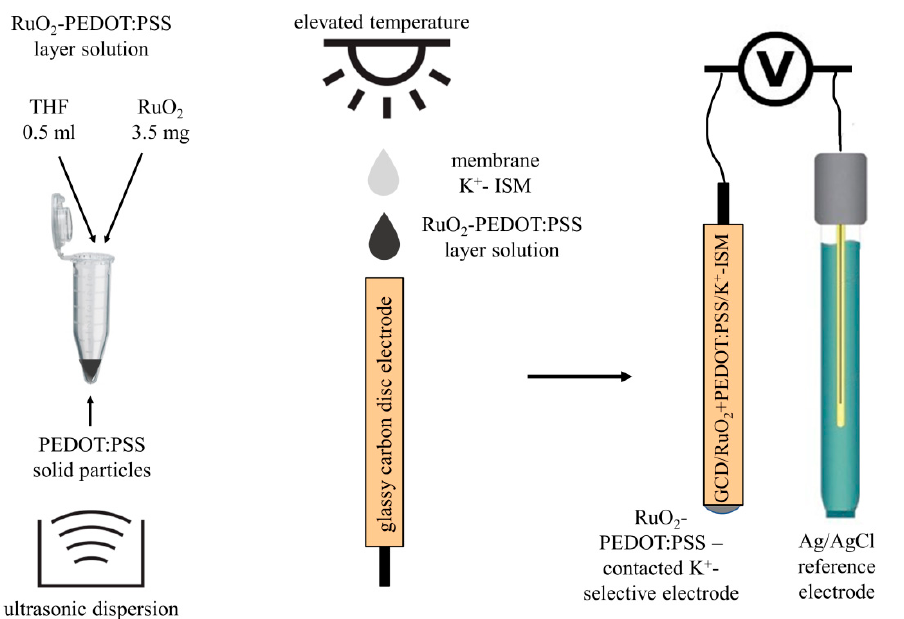
Figure 1. Preparation method of composite ruthenium dioxide (RuO 2 )-poly(3,4-ethylenedioxythiophene) polystyrene sulfonate (PEDOT:PSS) material and RuO 2 -PEDOT:PSS-contacted K + -selective electrodes.